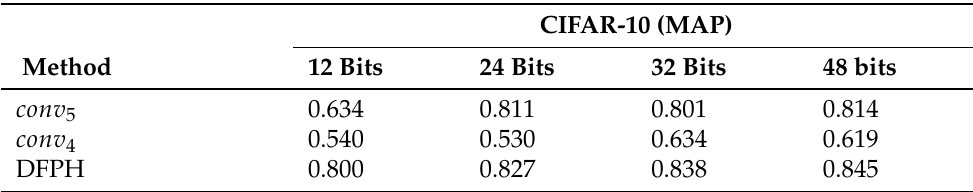
Table 5. Mean Average Precision (MAP) of Hamming ranking of different scales for different number of bits on CIFAR-10.